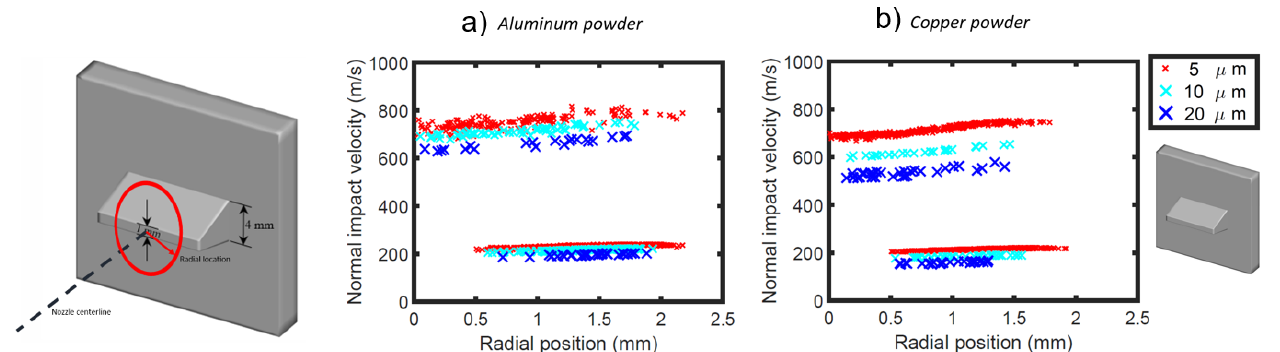
Figure 11. Normal impact velocities and radial location of ( a ) aluminum and ( b ) copper particles for the case with the inclined wall. The left image is prepared to show that the flow is not axisymmetric and the particles impact on both top and inclined planes.